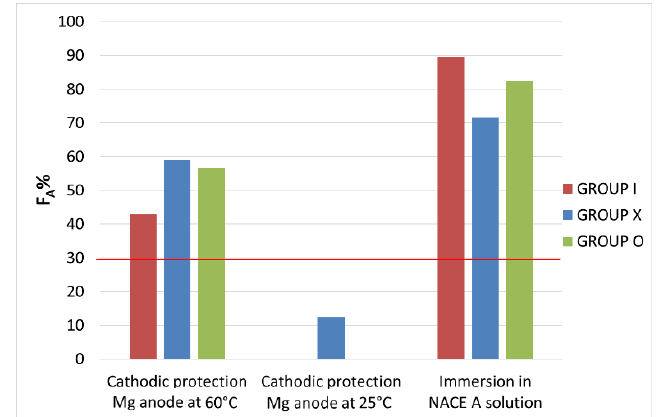
Figure 7. Embrittlement index calculated on elongation at break. The charging method is reported on the bottom and the red line corresponds to the threshold